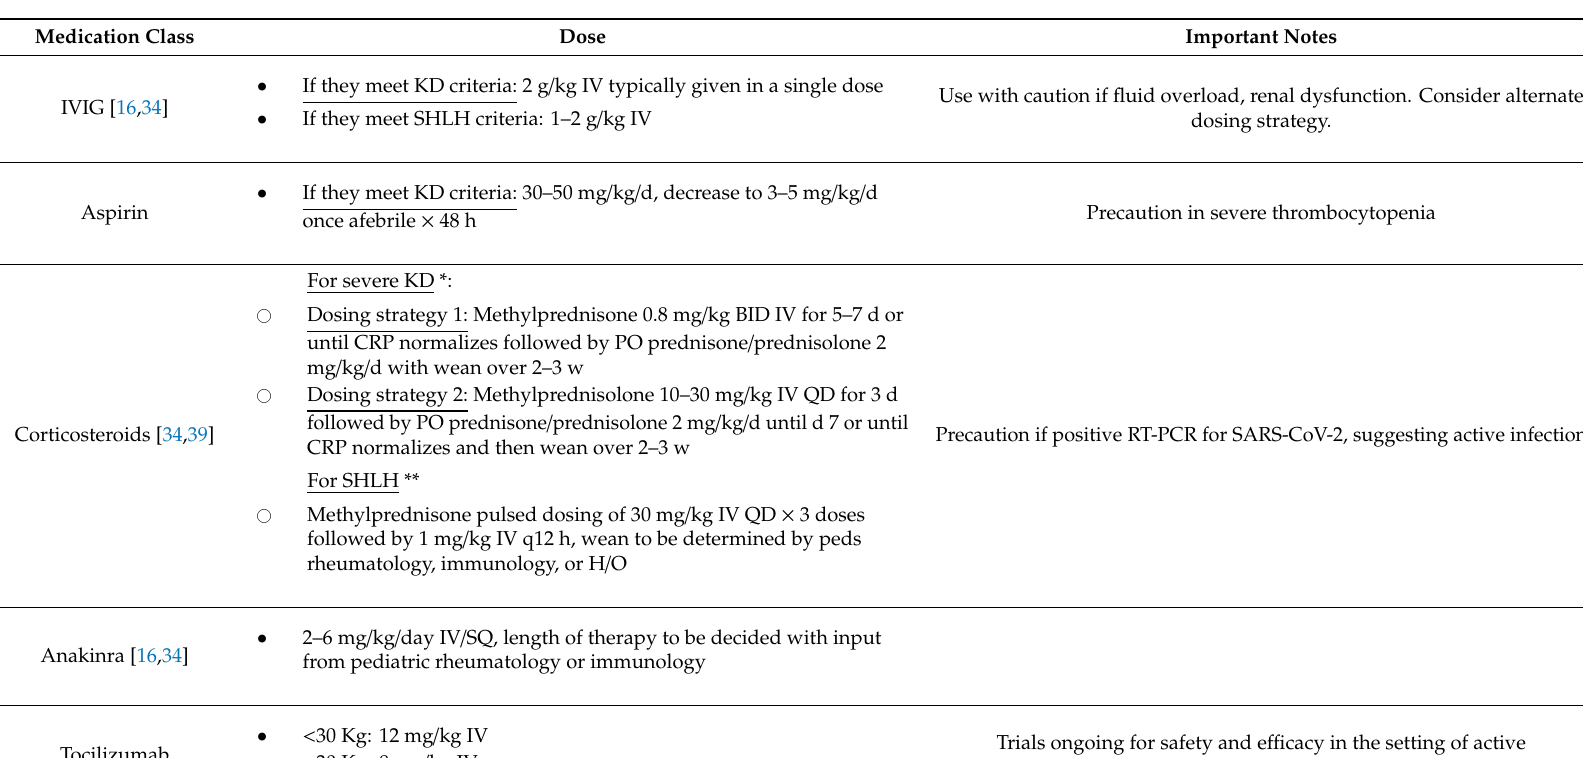
Table 3. Possible doses for immunomodulatory agents in the treatment of MIS-C, depending on phenotypic characteristics. Medication